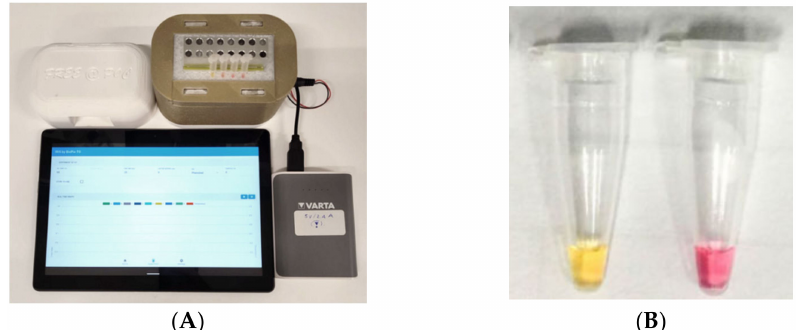
Figure 1. ( A ) Overview of the 3D-printed portable thermal block device. The plastic box contains a heating metal block, set to operate at 65 ◦ C for 30 min. The device is powered by a portable power bank and connected via Bluetooth to a tablet. ( B ) The positive reaction (amplified DNA) is visualized by the color change from pink (negative signal) to yellow (positive